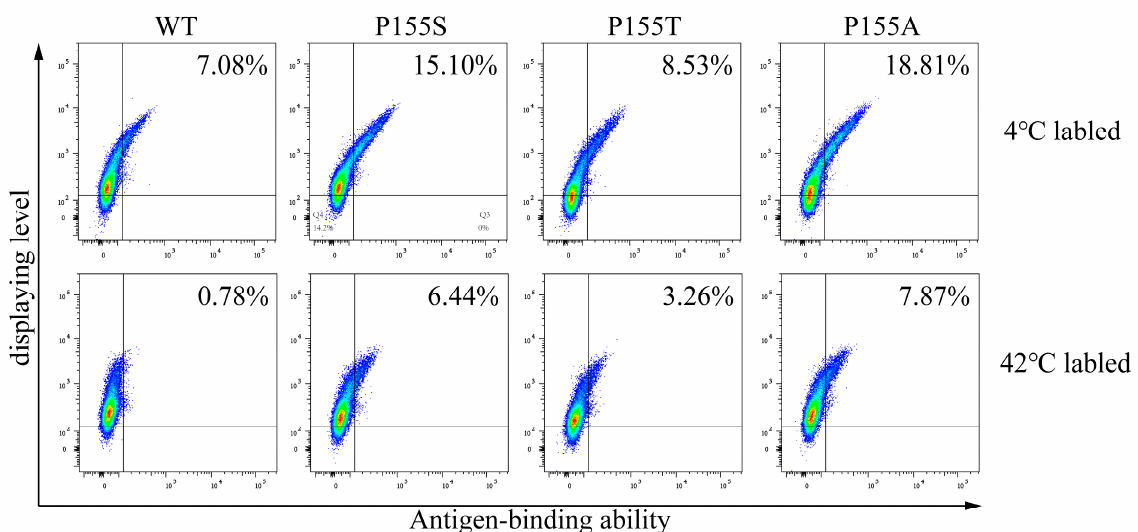
Figure 10. Analyses of the display levels and antigen-binding abilities of wild-type (WT) and mutants (P155S, P155A and P155T) labeled at 4 and 42 ◦ C. The antibody genes were transiently transfected into cells, respectively, and then were labeled at 4 and 42 ◦ C before flow cytometric analysis.